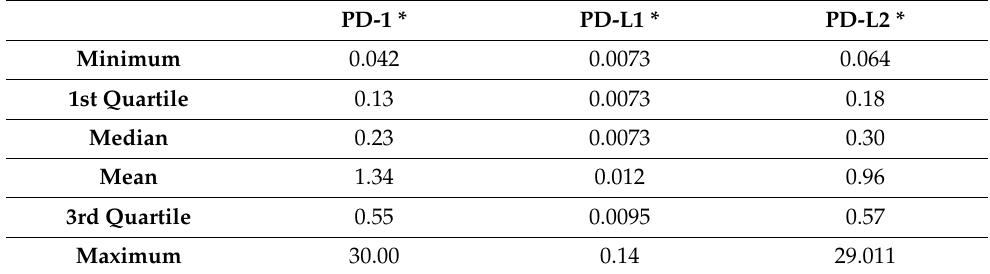
Table 4. Soluble PD-1, PD-L1 and PD-L2 concentrations measured in healthy male